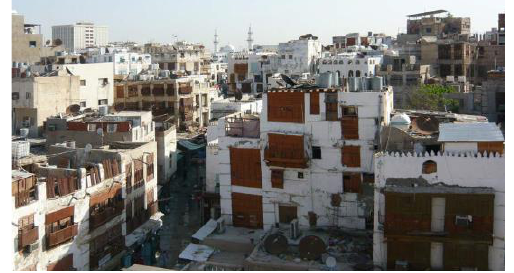
Figure 1. The dense fabric of the old city (Source: SCTA,